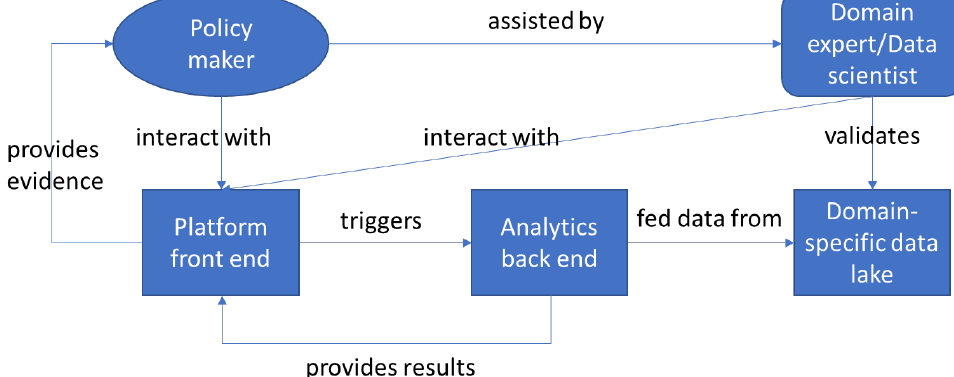
Figure 1. Data-Informed Policymaking Methodology.